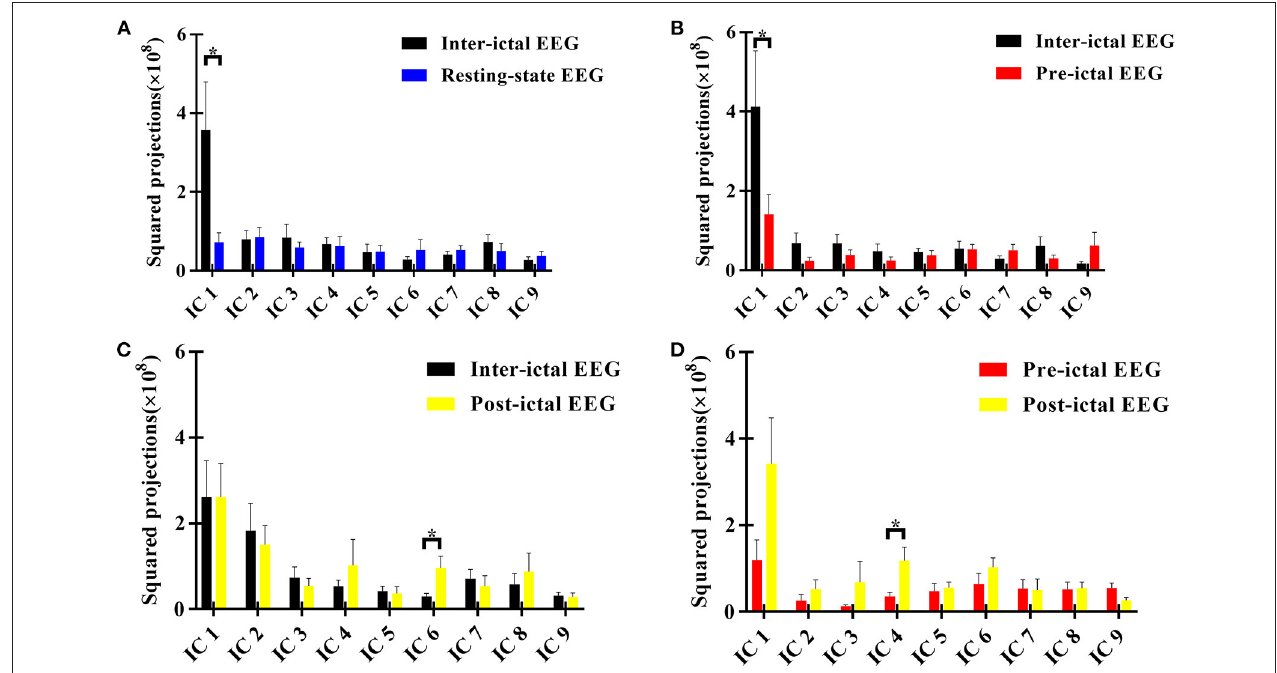
FIGURE 1 | Squared loading comparisons of the components*. (A) Inter-ictal EEG compared with the resting-state EEG data of HC group; (B) Pre-ictal EEG was compared with inter-ictal EEG within AE group; (C) Post-ictal EEG was compared with inter -ictal EEG within AE group; (D) Post-ictal EEG compared with pre -ictal EEG within AE group. * P < 0.05, two sample t- test between AE group and HC group, and paired t -test for different states within AE group. Those components with Z scores lower than 3 were not taken into comparisons. IC, independent component. The null distribution between two conditions was evaluated by Monte-Carlo simulation with a repetition of 1,000,000 iterations ( P <